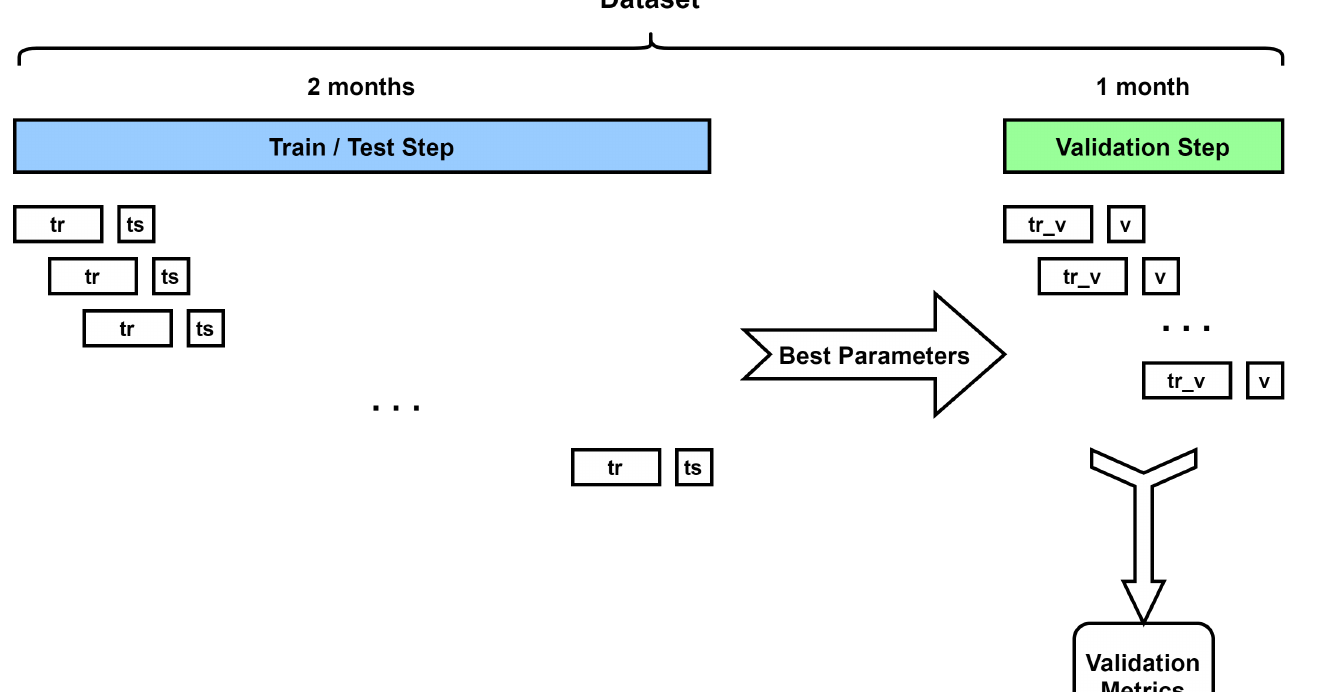
The first stage is to obtain the data to be used, which consists of a univariate time series (only one variable) that will serve as input to the models to be compared. This time series is formed by the electricity price of the period of time to be studied, which can be obtained from the e-sios website. As in [12], we have used the Multi-Input Multi-Output (MIMO) technique 275 to train and evaluate the models. The MIMO strategy increases the predictions’ accuracy since it does not accumulate previous predictions’ errors. This strategy makes use of a sliding window scheme to create the input-output pairs that will 13